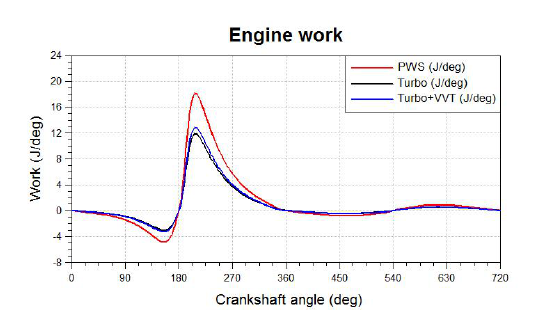
Figure 12. Mechanical engine work for the 3 setups.